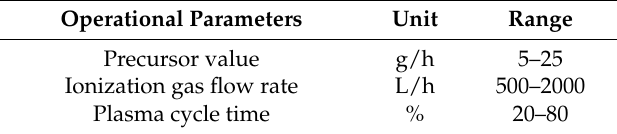
Table 1. Operational parameters studied used in the experiment.